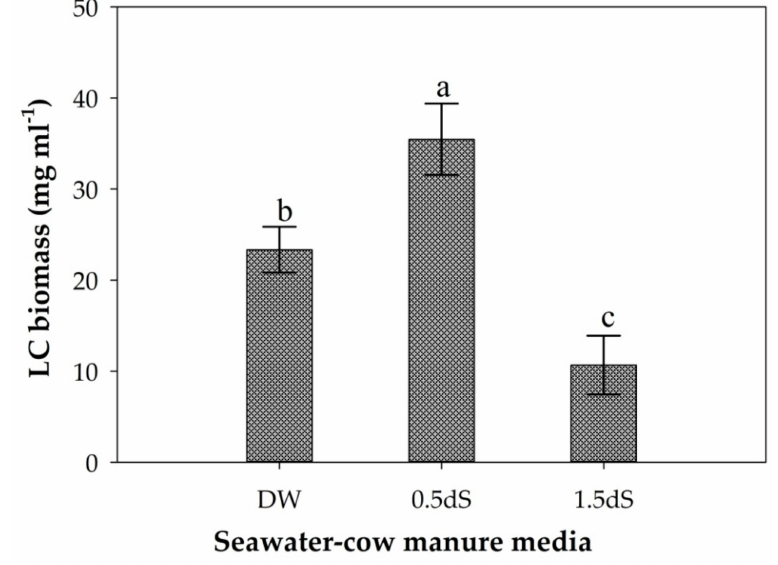
Figure 8. E ff ect of natural seawater and cow manure media on salt sensitive cyanobacteria (LC) biomass production. DW = cow manure with distilled water, 0.5 dS = cow manure with natural seawater at an EC of 0.5 dS / m, 1.5 dS = cow manure with natural seawater at an EC of 1.5 dS / m. The error bars represent standard deviation (SD). The data are the mean of three replicates. Di ff ering letters indicate significant di ff erences of means of LC cyanobacterial biomass production in pairwise comparisons (Tukey’s test p < 0.05) for each treatment by